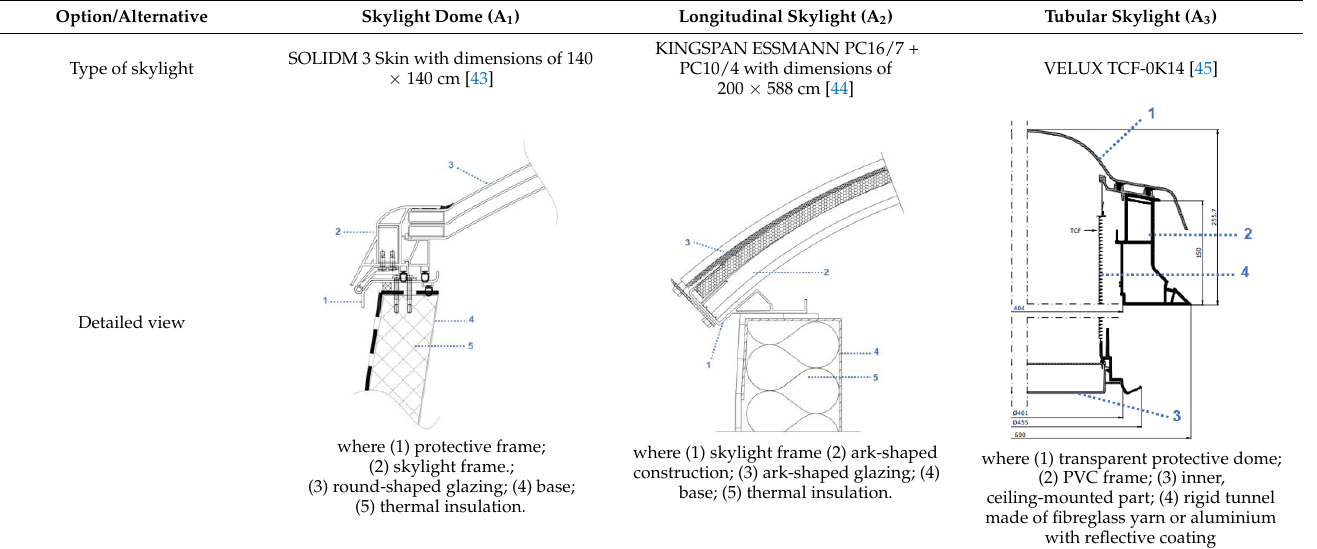
Table 2. The detailed view and some technical data of the selected skylight